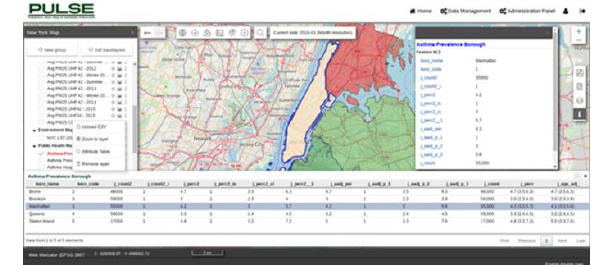
Figure 5. Query feature and attribute table